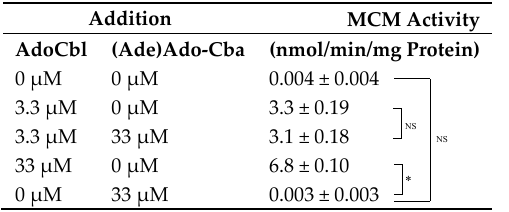
Molecules 2020 , 25 , x FOR PEER REVIEW Table 4. Effects of (Ade)Ado-Cba on the activity of apo-MCM in mammalian cells. Table 4. E ff ects of (Ade)Ado-Cba on the activity of apo-MCM in mammalian cells.